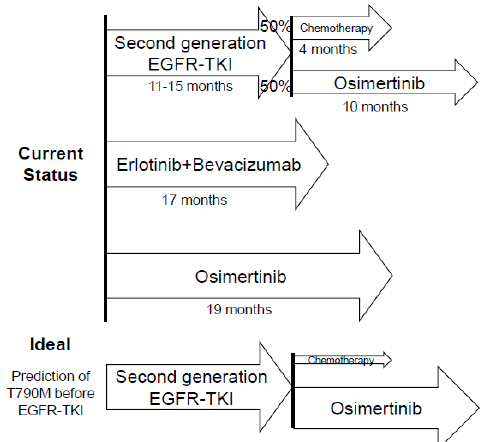
Figure 1. Current and potential ideal sequential treatment regimens with EGFR-TKIs in patients with advanced NSCLC harboring EGFR mutations. Median PFS values are indicated.